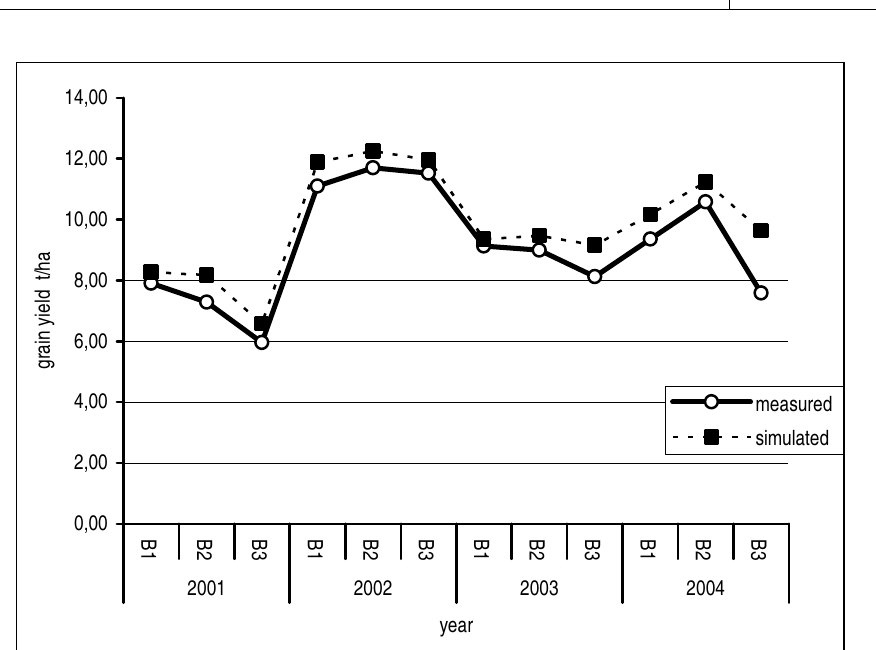
Fig 2 . Measured and simulated grain yields in Dolna in Malanta in